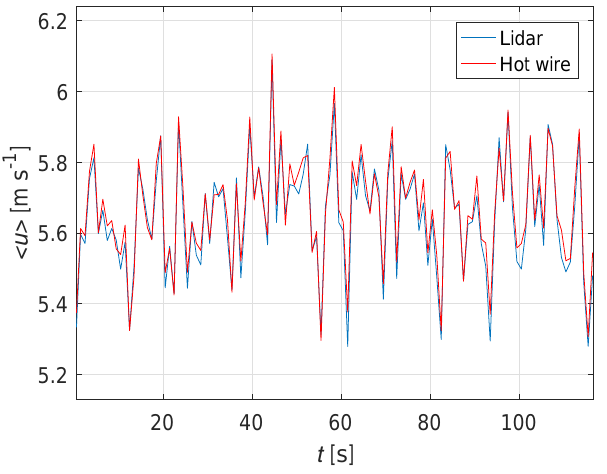
15 were correlated with each other, as shown by Figs. 16 and 17. The mentioned effects that caused the scatter in the corre- lated 390 Hz data of Figs. 12 and 13 no longer play a large role after the data have been averaged to 1 Hz time